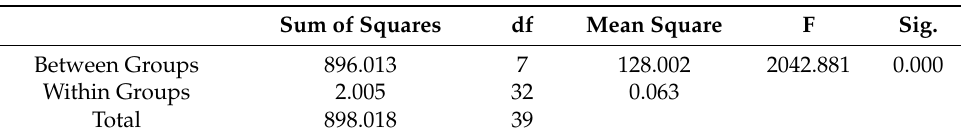
Table 11. ANOVA for Dataset